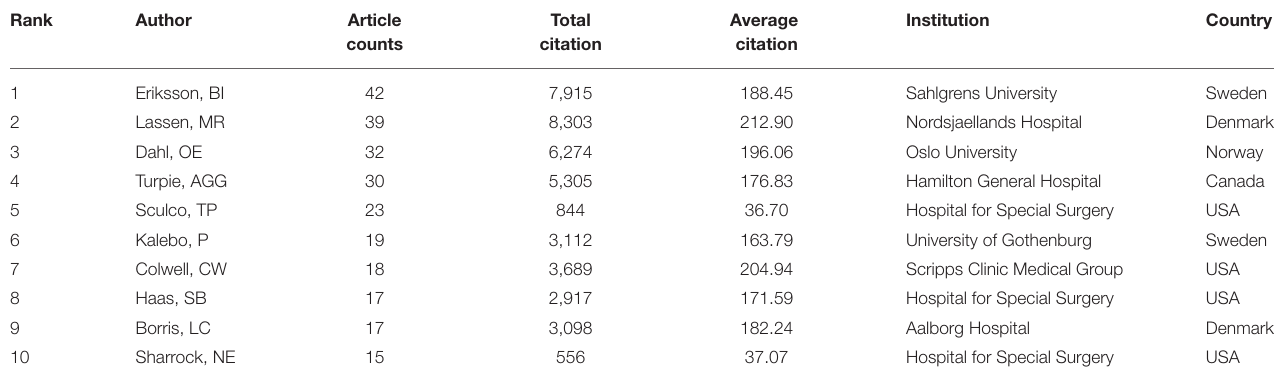
TABLE 3 | Top 10 most prolific authors on VTE research after hip or knee